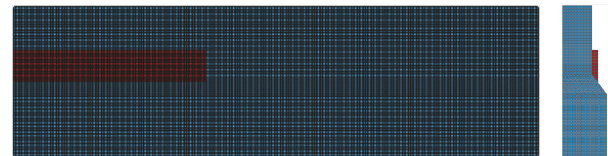
Figure 9: The front view and side view of calculation model of blasting excavation of rock-anchored beam (unit: m).